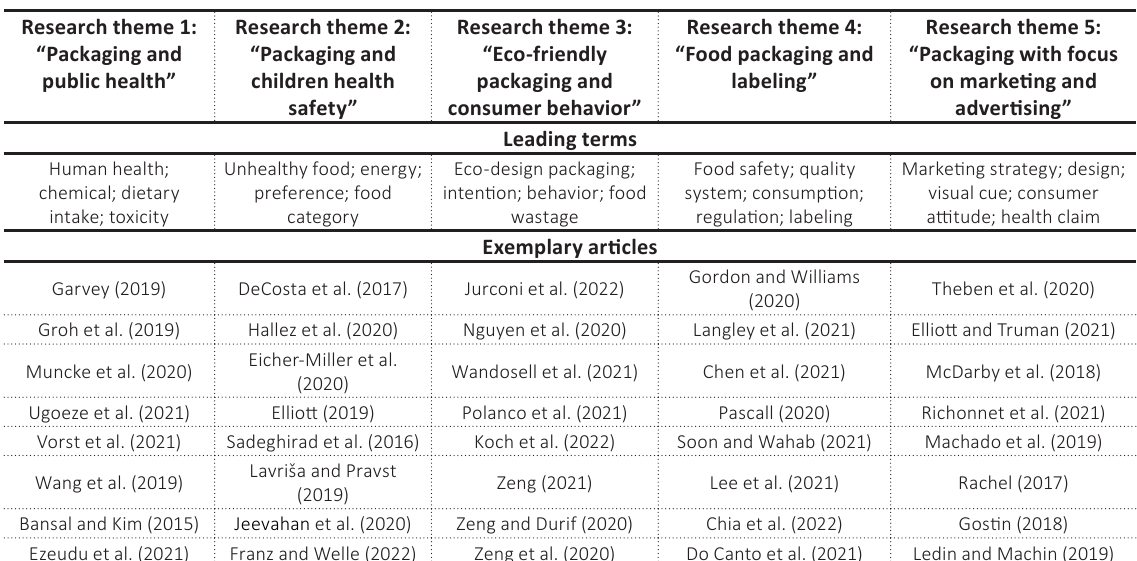
Table 2. Salient research